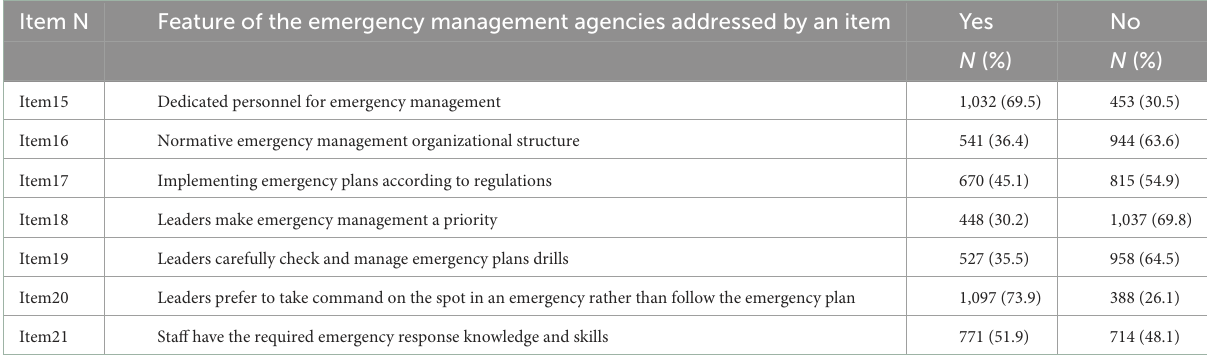
TABLE 3 Questionnaire responses to items about the “implementation